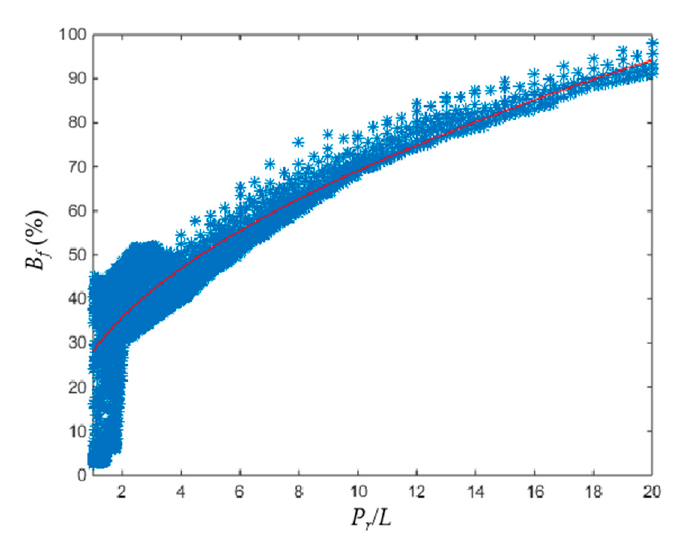
/ load ( P / L ) and its fitting r